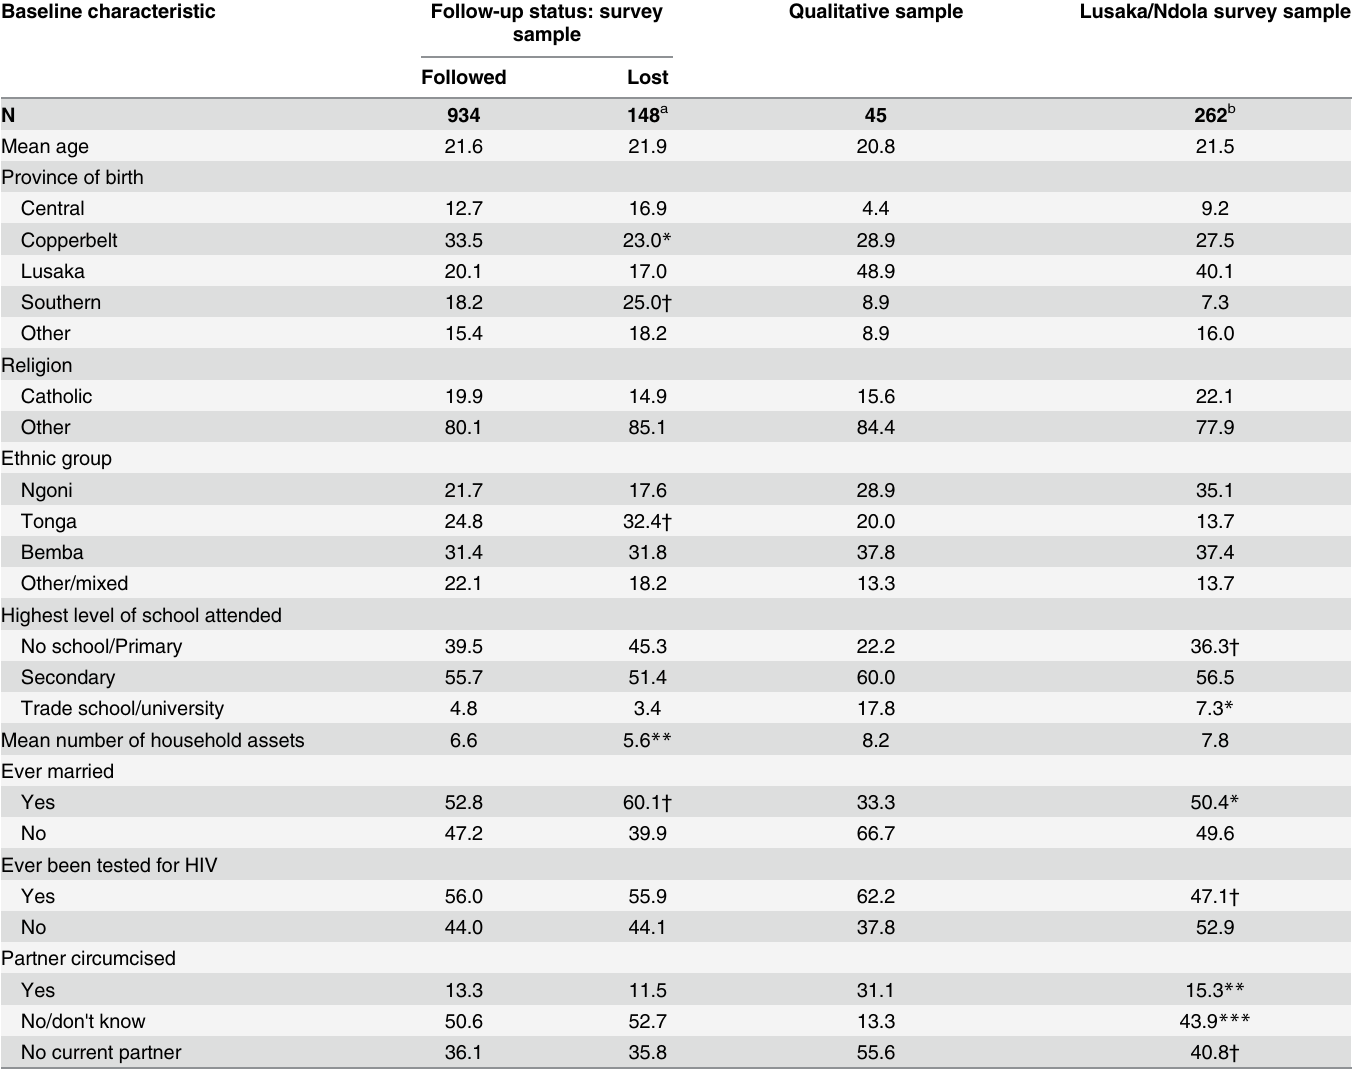
Table 1. Selected sociodemographic characteristics at baseline, by follow-up status and survey sample. Baseline